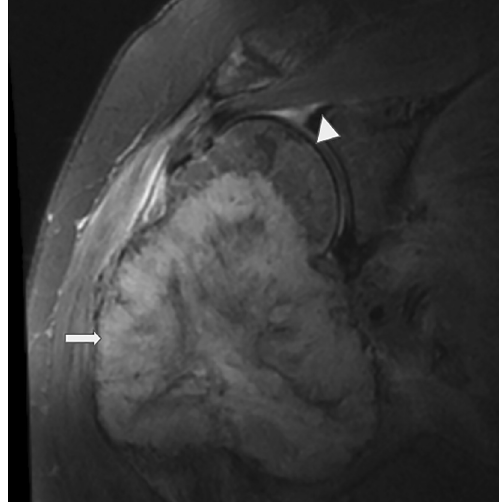
Image 3. Magnetic resonance imaging of the right humerus demonstrates a large, heterogeneous mass (arrow) adjacent to the right humeral neck and head, which extends peripherally into the soft tissues, representing malignancy. Arrowhead denotes the normal humeral